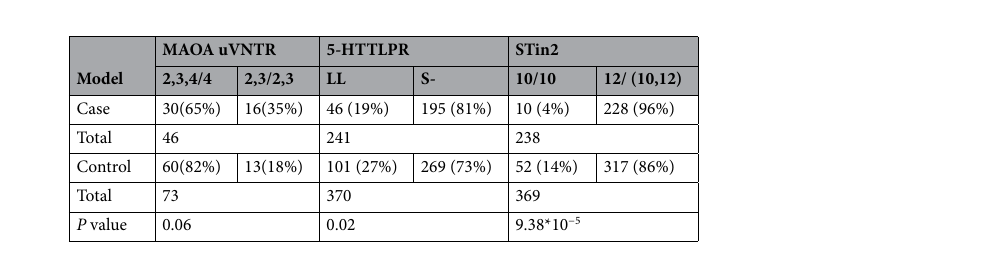
Table 5. Genetic model of 5-HTTLPR and STin2. S-: SS and